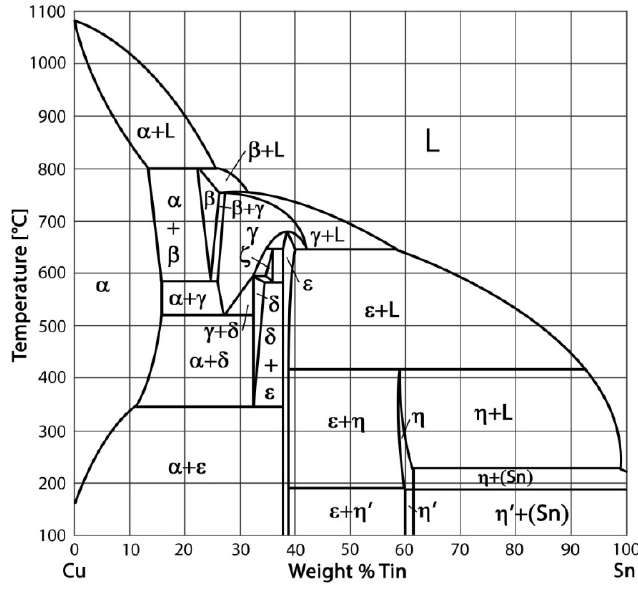
Figure 1. Phase diagram of Cu–Sn binary system.